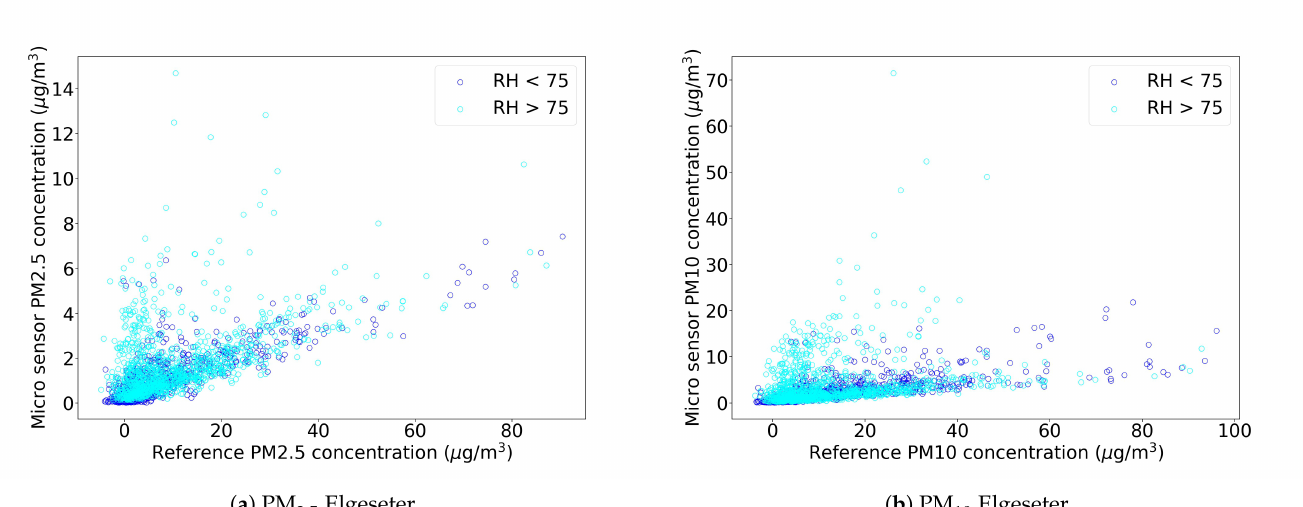
Figure 5. Scatter plots between low-cost sensor data and references with data collected between 15 November 2020 and 23 February 2021 at Elgeseter